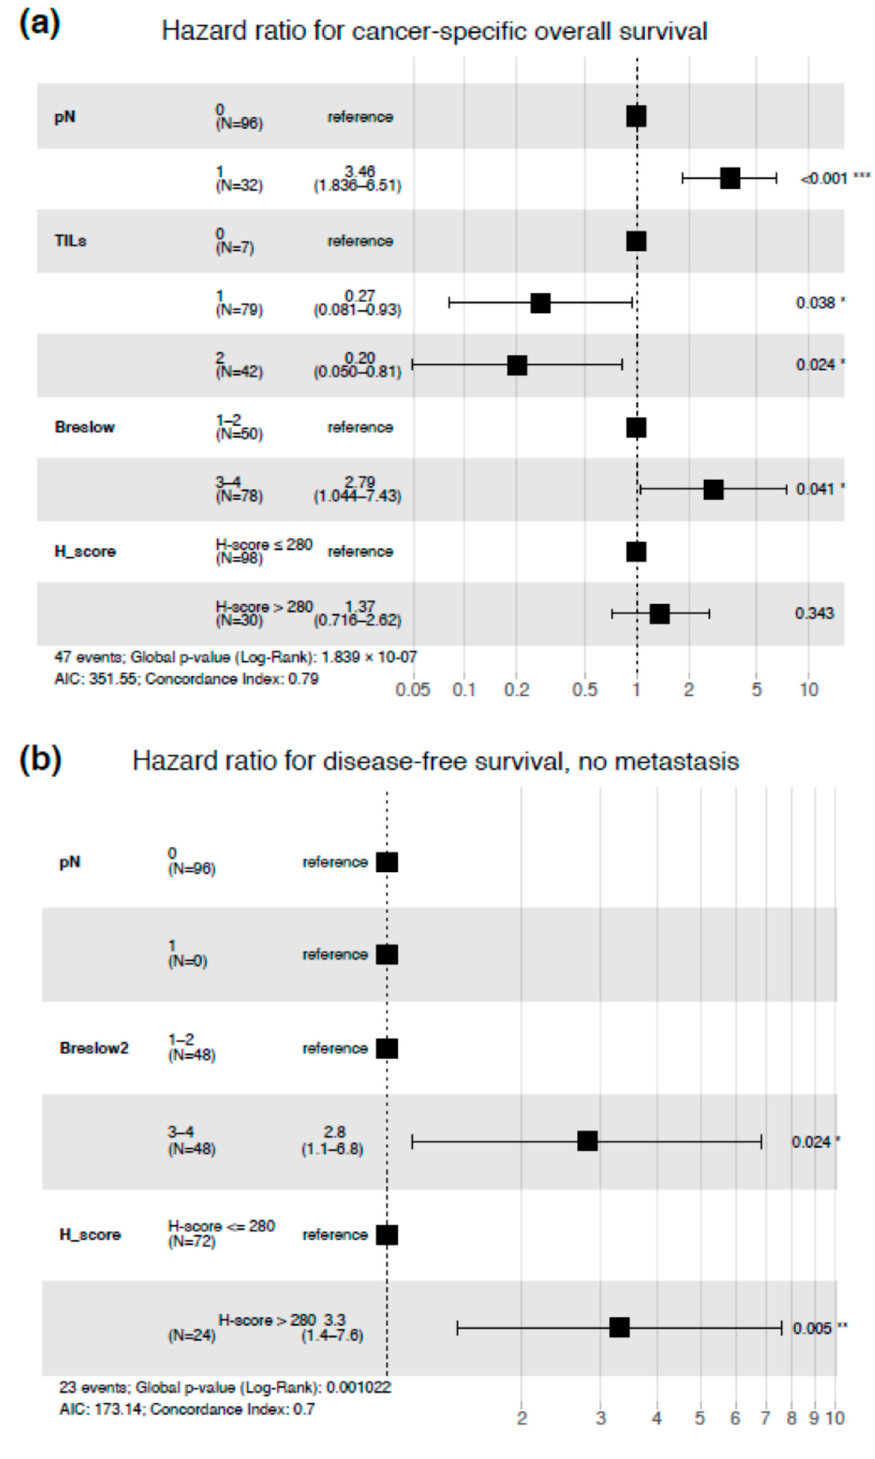
Figure 5. Multivariable regression model for cancer-specific overall survival in the entire study group of cutaneous melanoma patients ( a ) and multivariable regression model for disease-free survival in lymph node-negative melanoma patients. TILs = tumor-infiltrating lymphocytes ( b ). Stars corresponds to statistical significance, * stands for p-value < 0.05, ** for p-value < 0.01, *** for p-value < 0.001.